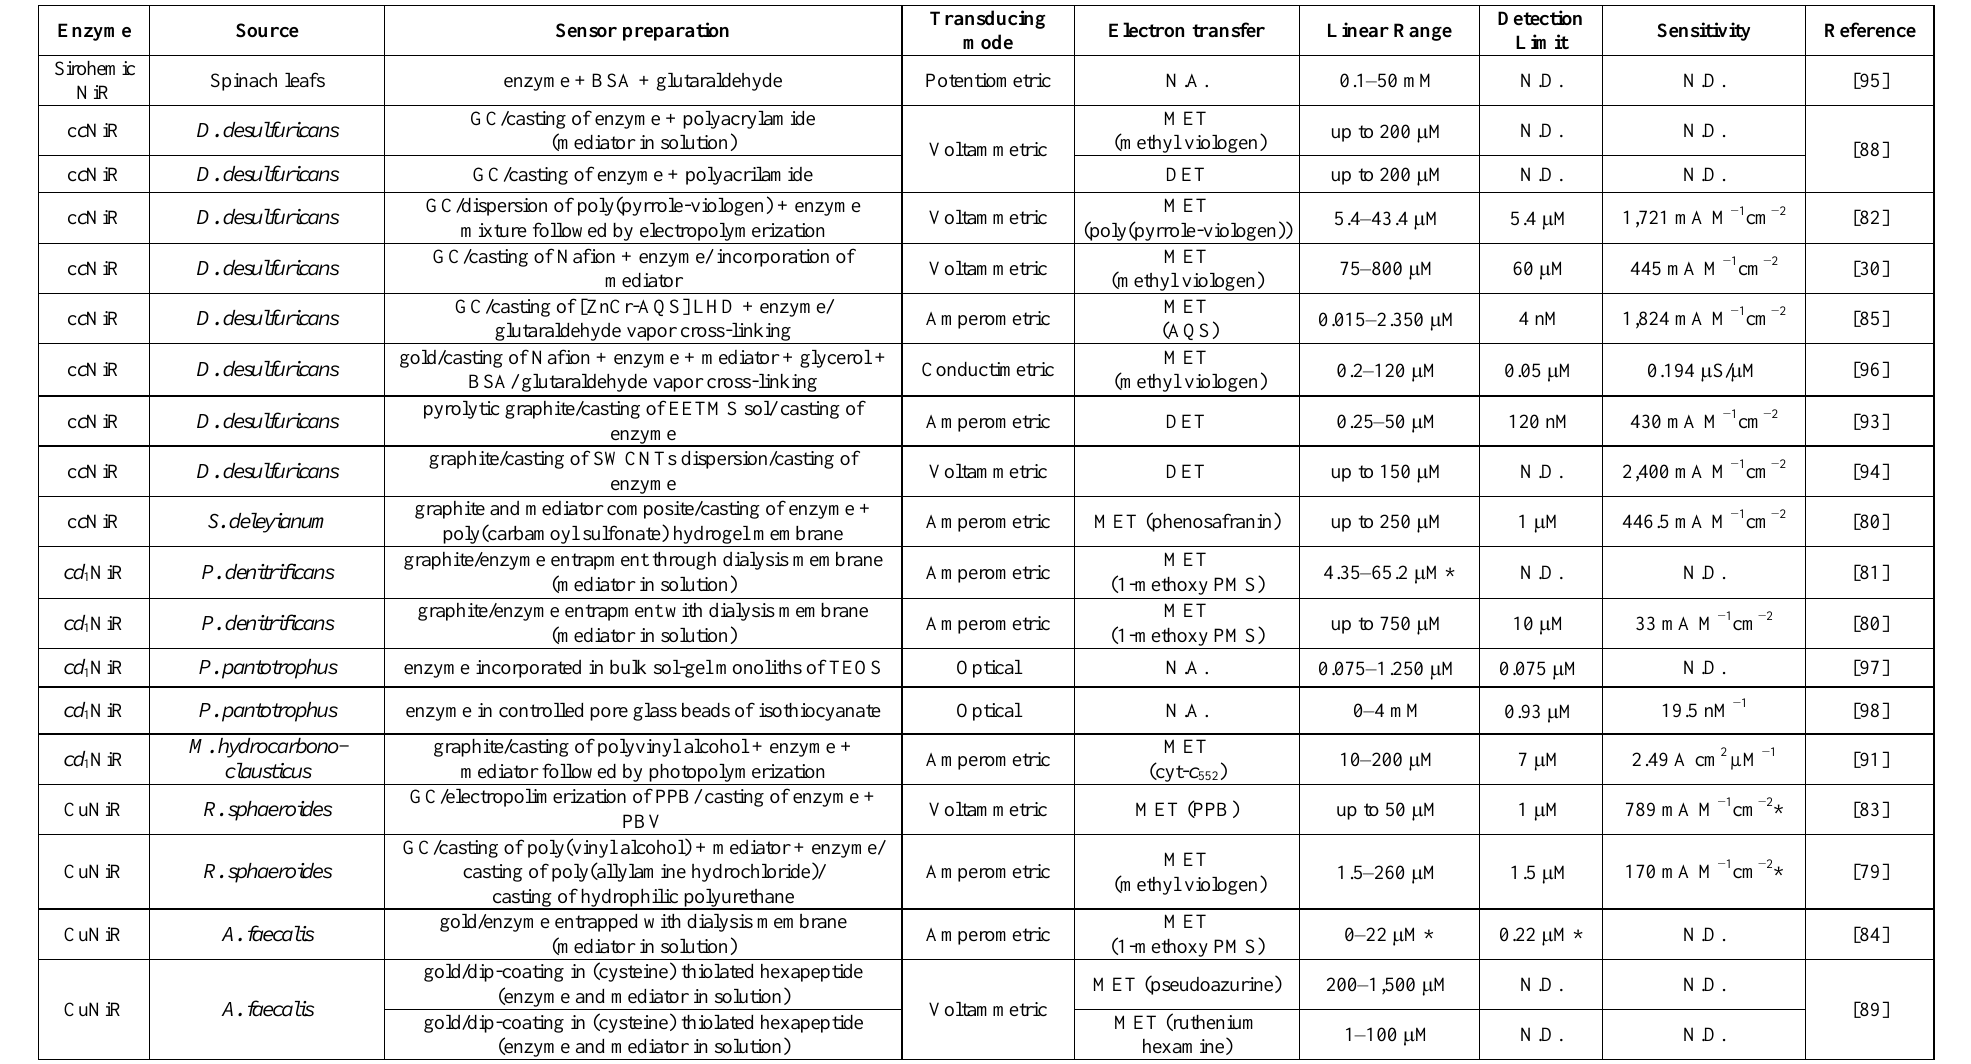
Table 2. Description and analytical parameters of nitrite reductase based biosensors (N.A.—not applicable; N.D.—not